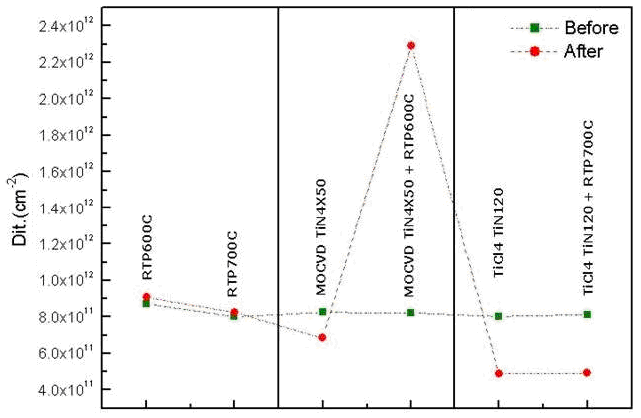
Figure 5. MOCVD TiN’s impurity is activated by RTP thermal which shows much higher D it than that of TiCl 4 -based